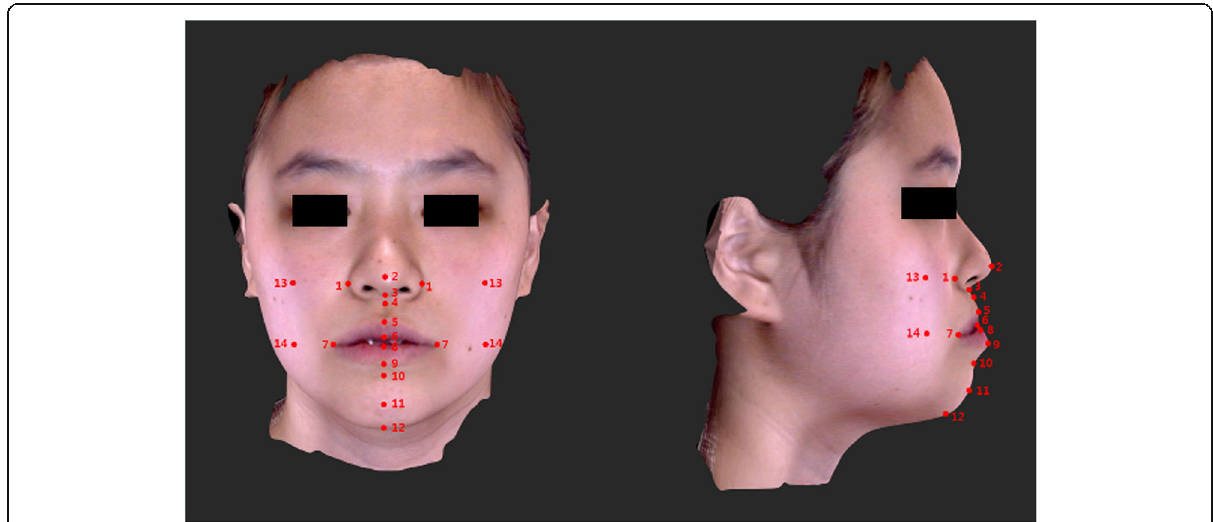
Fig. 3 Soft tissue landmarks on facial scan images. 1, nasal ala (Al dev/ctl); 2, pronasale (Pn); 3, subnasale (Sn); 4, A ’ point; 5, labrale superius (Ls); 6, stomion superius (Smts); 7, cheilion (Ch dev/ctl); 8, stomion inferius (Stmi); 9, labrale inferius (Li); 10, B ’ point (B ′ ); 11, pogonion ’ (Pog ’ ); 12, menton ’ (Me ’ ); 13, zygomatic point (Zy dev/ctl); and 14, cheek point (Ck dev/ctl). See also Table 2 for the description of 3D soft tissue landmarks